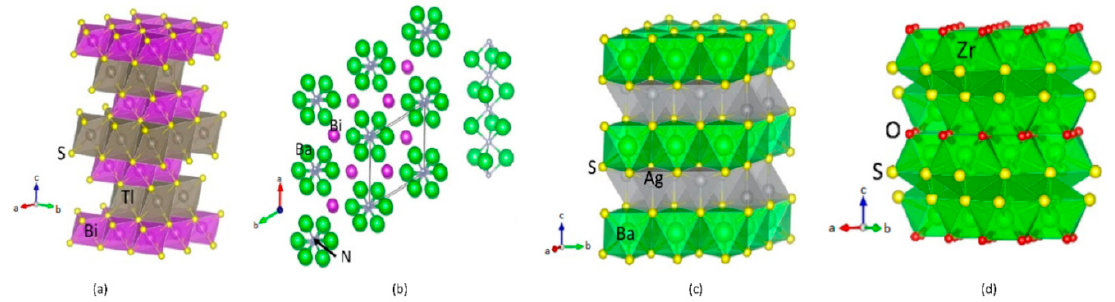
Figure 1. Crystal structures for ( a ) TlBiS 2 ; ( b ) Ba 3 BiN; ( c ) Ag 2 BaS 2 ; ( d ) Tetragonal-ZrSO. The illustration shows the legends for the different type of atoms.